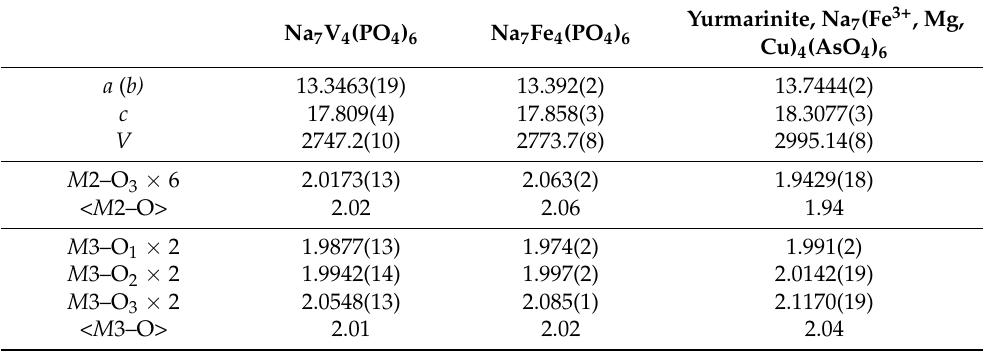
Table 4. Unit-cell parameters (Å), volumes (Å 3 ), and interatomic distances (Å) for V/Fe octahedra in Na 7 V 4 (PO 4 ) 6 , Na 7 Fe 4 (PO 4 ) 6 , and yurmarinite, Na 7 (Fe 3+ ,Mg,Cu) 4 (AsO 4 ) 6 crystal structures (space group R 3 c , Z = 6).